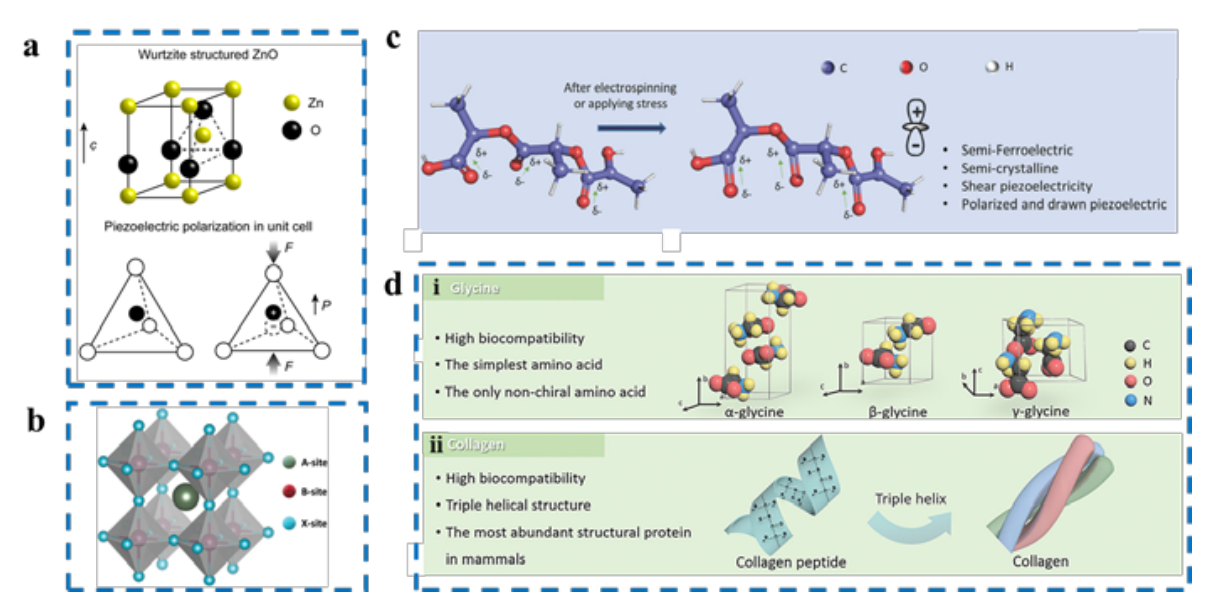
Figure 3. ( a ) Schematic diagram of ZnO piezoelectric mechanism [14] ; ( b ) schematic diagram of the structure of chalcogenide [18] ; ( c ) schematic diagram of the piezoelectric mechanism of piezoelectric polymers [16] ; ( d ) schematic diagram of the piezoelectric mechanism of bio-piezoelectric materials (i) glycine; (ii) collagen [19] .